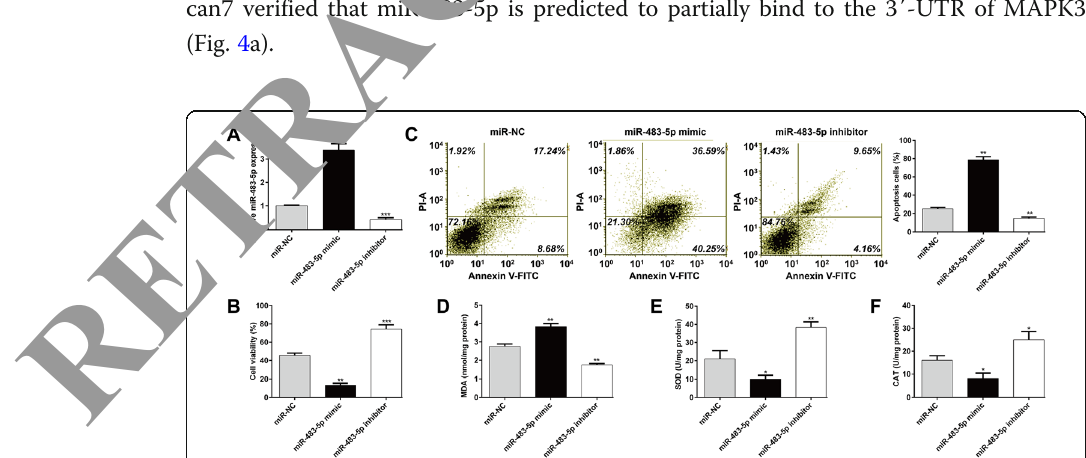
Fig. 3 MiR-483-5p influenced cardiomyocyte apoptosis and oxidative stress following hypoxic injury. AC16 cells were transfected with miR-483-5p mimic or inhibitor, followed by 24 h hypoxia treatment. a Quantitative real-time PCR was used to determine the expression of miR-483-5p. b Cell viability was measured using a CCK-8 assay. c Cell apoptosis was analyzed using flow cytometry with double Annexin V FITC-PI staining. d through f The content of MDA and the activities SOD and CAT were measured using commercial assay kits. Data are indicated as means ± SD of three independent experiments. * p < 0.05, ** p < 0.01, *** p < 0.001, as compared with